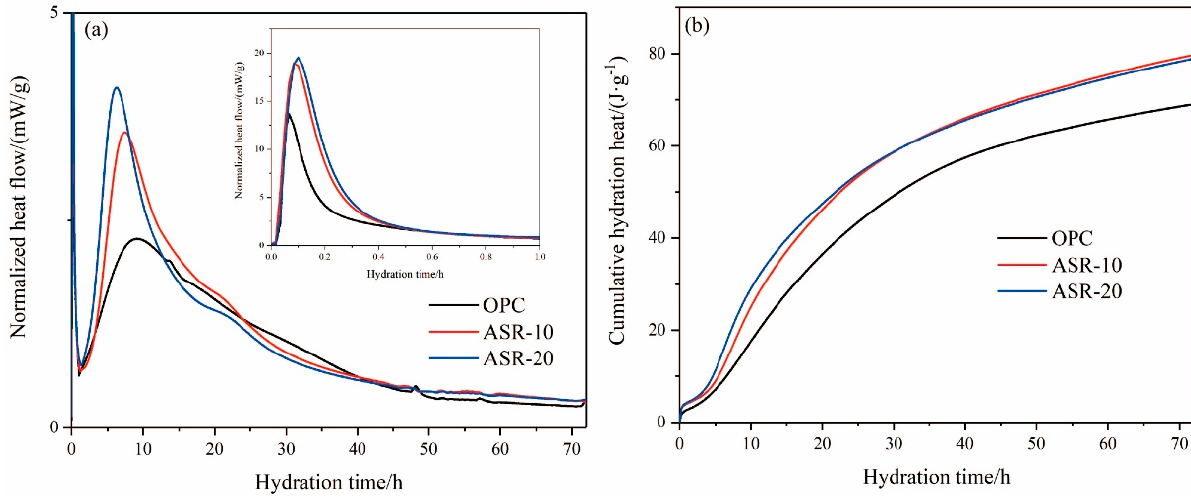
Figure 6. The hydration heat of varying pastes within 72 h: ( a ) normalized heat flow; ( b ) cumulative hydration heat.